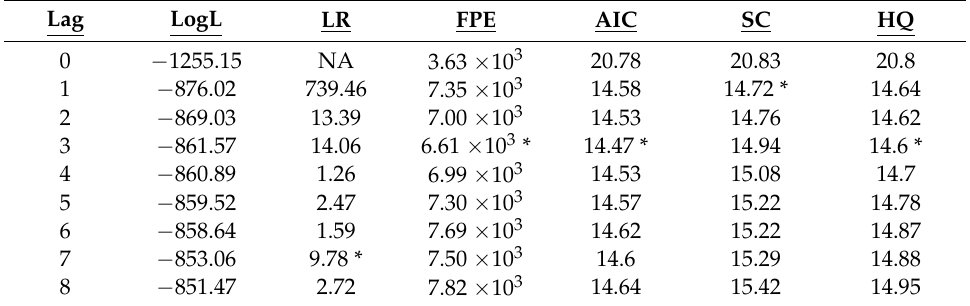
Table A3. VAR lag order selection criteria. Endogenous variables: Oil price and exchange rate.